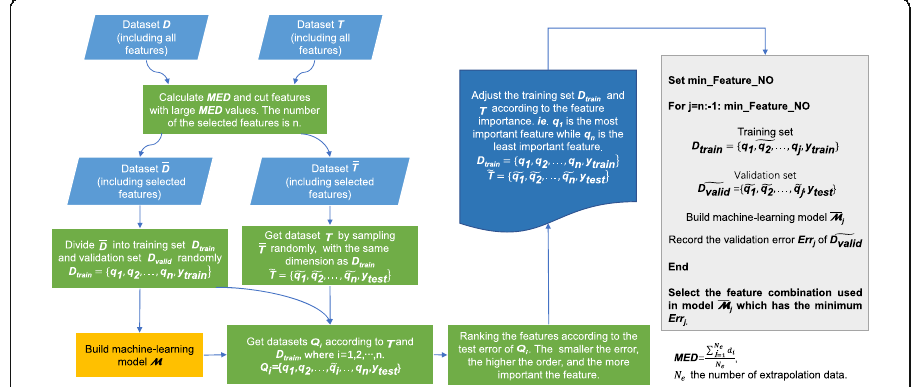
Fig. 4 The procedure of feature